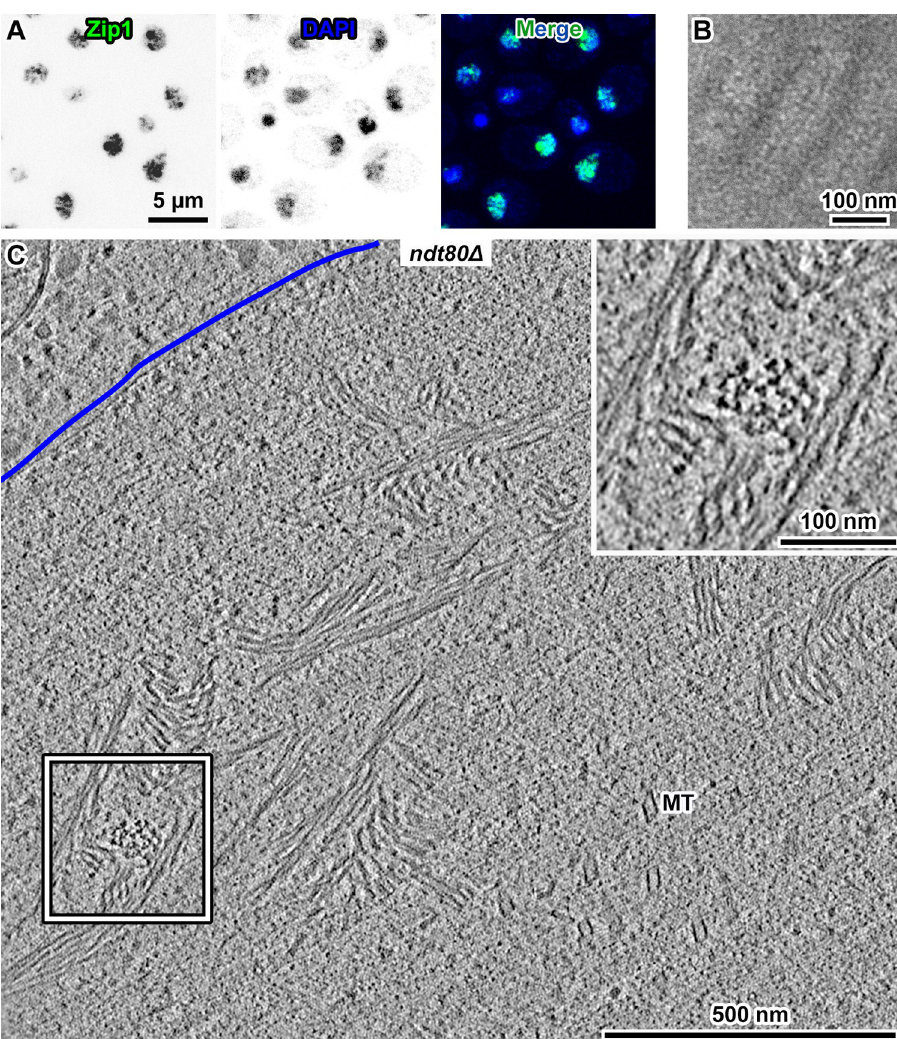
ndt80 Δ cells, after 8 hours in SM. Zip1-GFP fluorescence is found at both SCs (weak fluorescence) and polycomplexes (large, bright fluorescent bodies). The chromatin is stained by DAPI. (B) Plastic section showing a portion of a